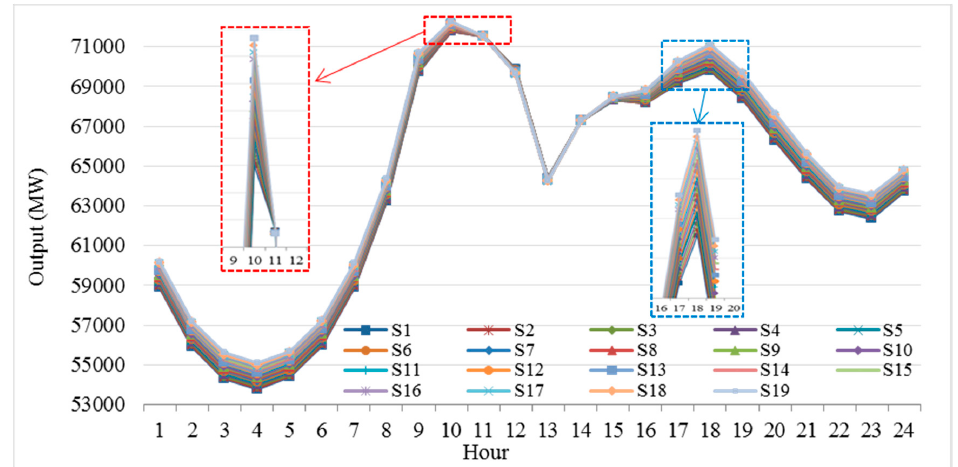
Figure 8. Net load profile for the VGR mix scenario.